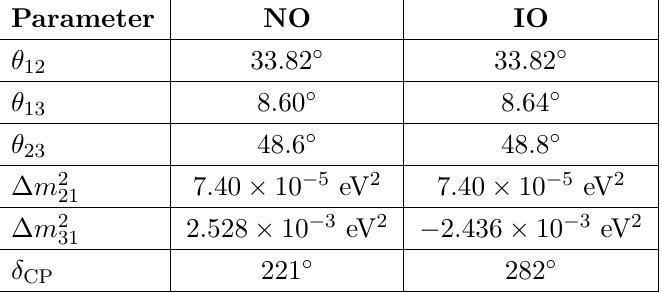
) and they are ij ij